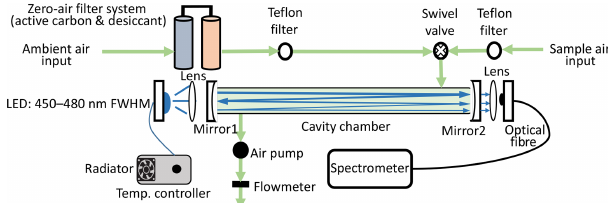
Figure 2. Schematic diagram of the experimental set-up of the CE-